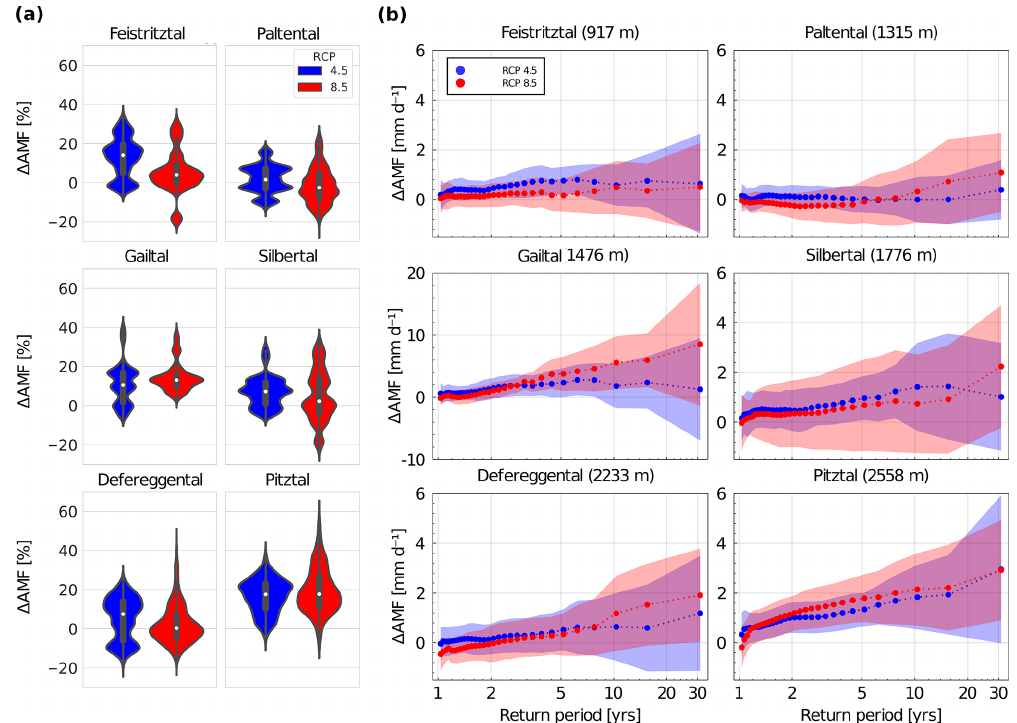
Figure 12. (a) Violin plots of the relative change in magnitude of AMF across simulations, based on average magnitude over 30-year time period of each simulation. (b) Simulation mean absolute change in magnitudes of AMF in relation to the return period. Shaded area indicates 1SD, and dotted lines are used for better visualization. Note the different scale for the Gailtal